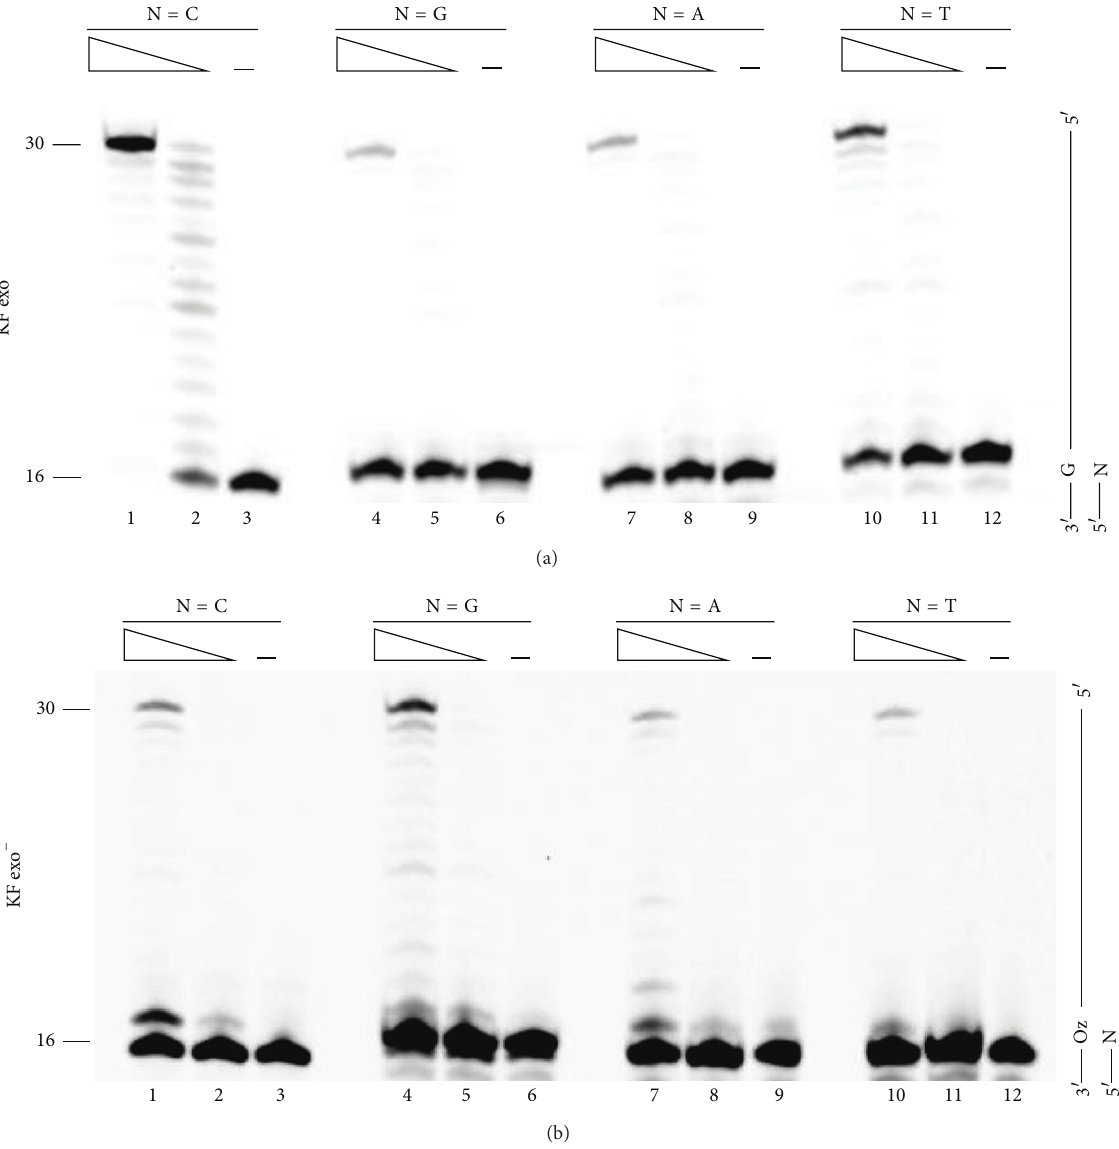
Figure 3: Extension from primer ends by KF exo − . Each primer contained a different nucleotide at the 3 󸀠 end (indicated by N, where N was C, G, A, or T in lanes 1–3, 4–6, 7–9, and 8–12, resp.) opposite G (a) or Oz (b). The amount of KF exo − was 250 𝜇 U in lanes 1, 4, 7, and 10 or 25 𝜇 U in lanes 2, 5, 8, and